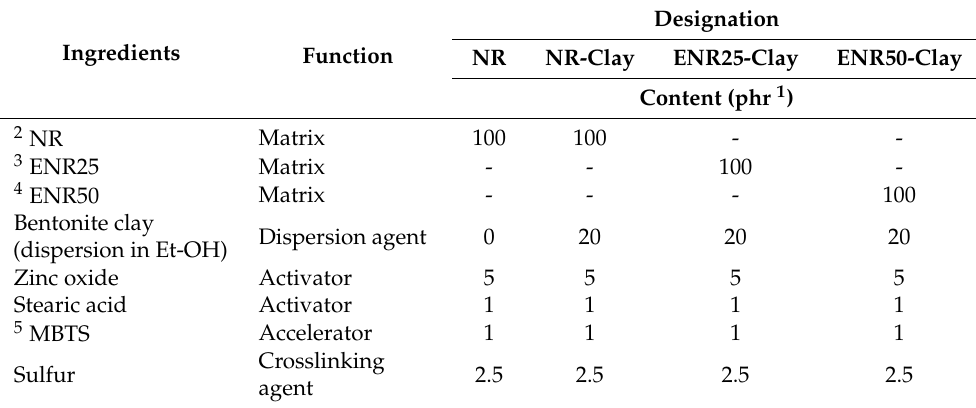
Table 1. Formulation of the rubber